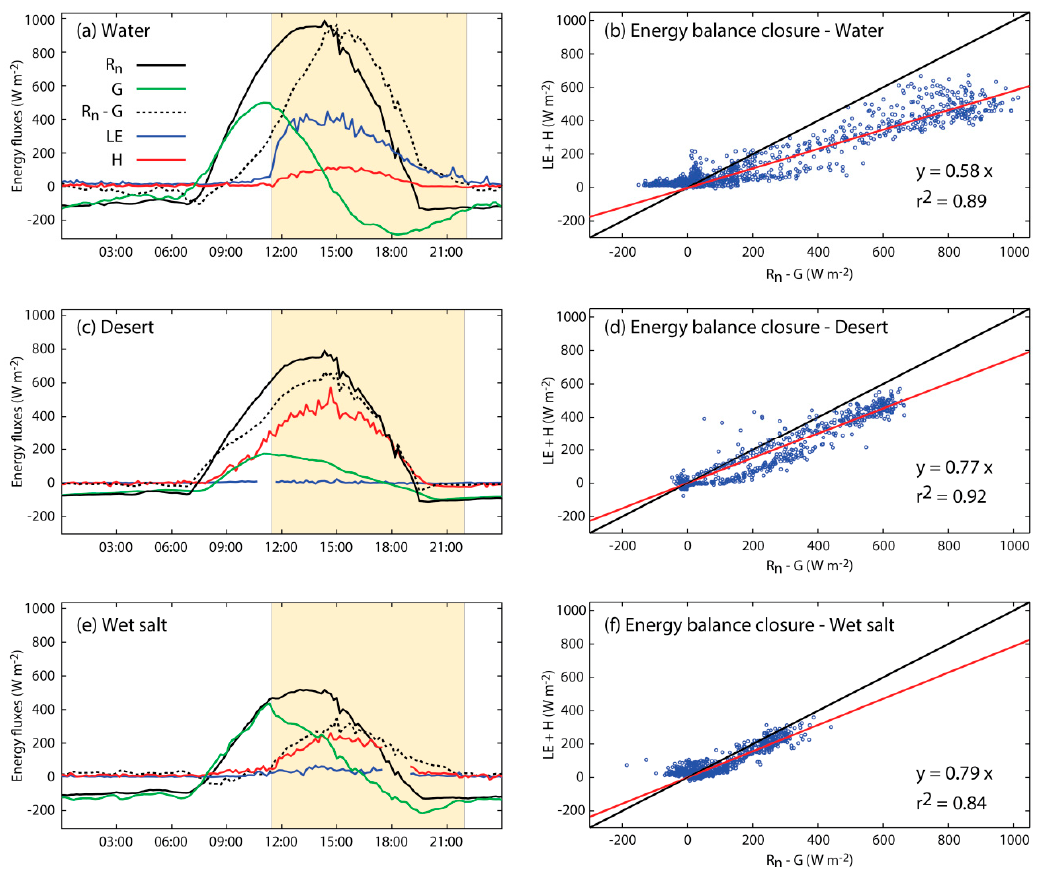
Figure 5. Characterization of the surface energy fluxes at the water, wet salt and desert surfaces, measured with the EC systems using an integration time of 10 min (17 November 2018). Left: temporal daily evolution of the surface energy fluxes ( R n , G , LE and H ) and the available energy ( R n – G ) for the water ( a ), desert ( c ) and wet-salt ( e ) surfaces. The yellow background corresponds to the time period of the afternoon wind regime in which the wind speed is significant ( > ~4 m s − 1 ). Right: energy balance closure at the water ( b ), desert ( d ) and wet-salt ( f ) surfaces. The black line corresponds to the 1:1 line, the red line is the fitted line from orthogonal regression and the dots correspond to the 10-min values of ( R n − G ) and ( LE + H ).